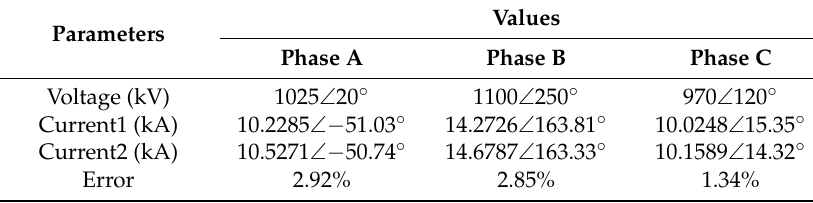
Table 4. Measured currents at the second group of voltages.